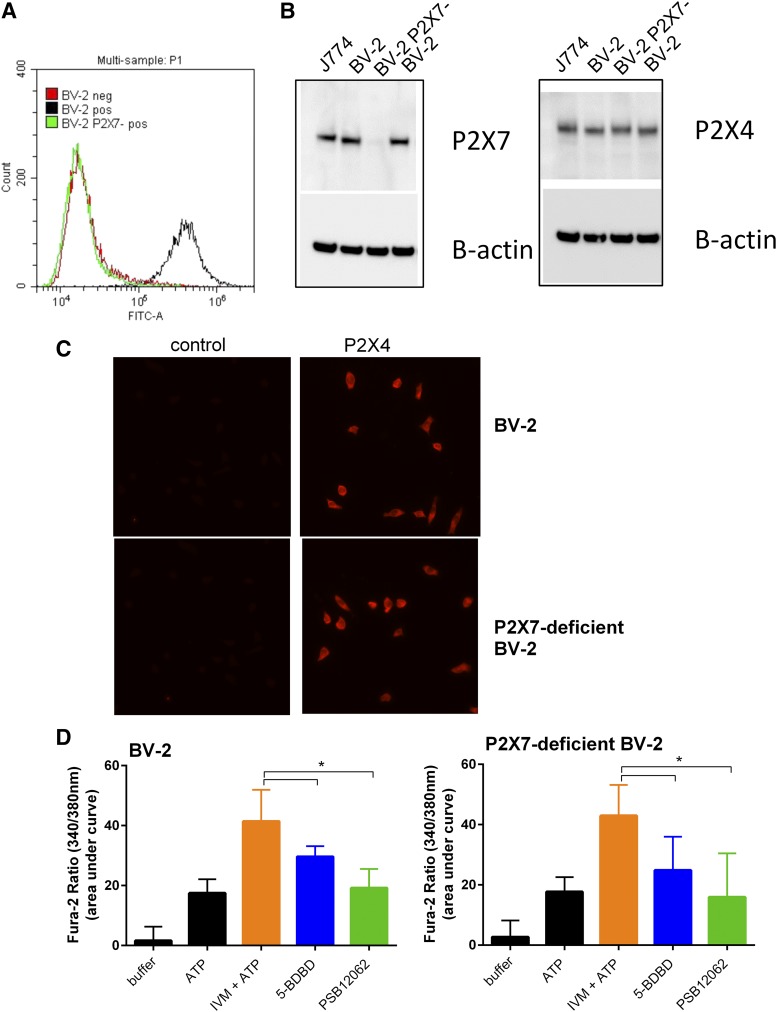
P2X4 responses in gene-edited BV-2 cells to eliminate P2X7 receptors. BV-2 cells deficient for P2X7 were generated using CRISPR/Cas9 editing. (A) Flow cytometry data indicating parental BV-2 cells express P2X7 (black histogram), whereas P2X7-deficient BV-2 cells show no P2X7-positive stain (green histogram) using Hano43 antibody labeling. Red histogram indicates negative control, cells labeled with secondary antibody only. (B) Western blots showing no anti-P2X7 reactive protein band in P2X7-deficient BV-2 cells compared with parental BV-2 and J774 macrophages. Equal amounts of protein (25 μg) were loaded per lane as indicated by the β-actin loading control on stripped and reprobed blots. P2X4 protein levels were unchanged following knockout of P2X7. (C) Staining for P2X4 receptors was performed using a fix/perm method with cells grown on 13-mm glass coverslips. Rabbit anti-P2X4 (1:200) was used to label all P2X4 receptors in BV-2 parental and P2X7-deficient BV-2 cells. Images are representative of two independent experiments. (D) Intracellular calcium measurements in Fura-2 acetoxymethyl ester–loaded BV-2 and P2X7-deficient BV-2 show identical ATP (25 µM) responses. ATP + ivermectin (3 µM) responses were reduced by pretreatment of cells with 5-BDBD (10 µM) or PSB-12062 (1 µM). Error bars are S.D. and *P < 0.05, one-way ANOVA with Dunnett’s multiple comparison post hoc test.